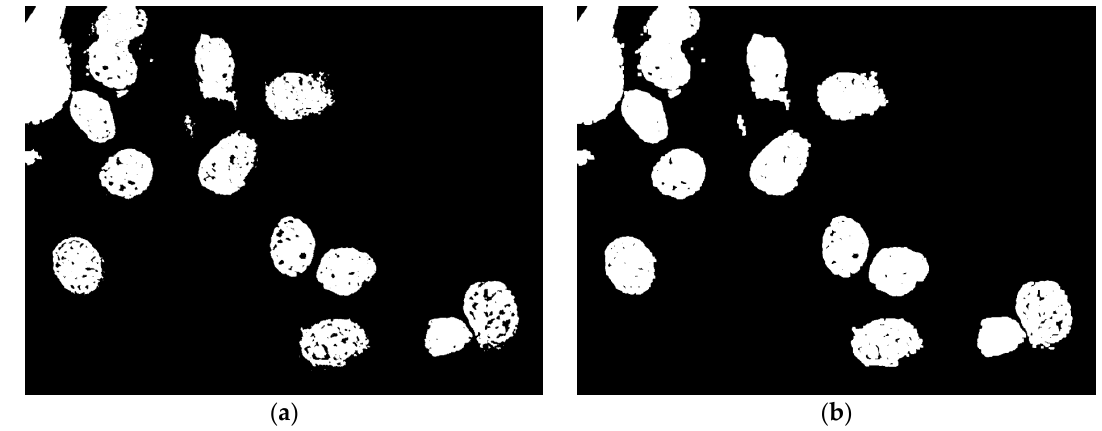
Figure 7. Output images of Otsu’s binarization ( a ) and morphological operations ( b ).